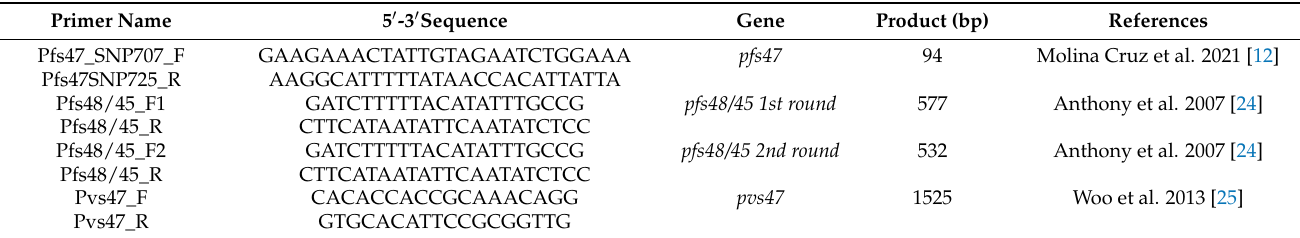
Table 1. Primers used to amplify the pfs47 , pfs48/45 , and pvs47